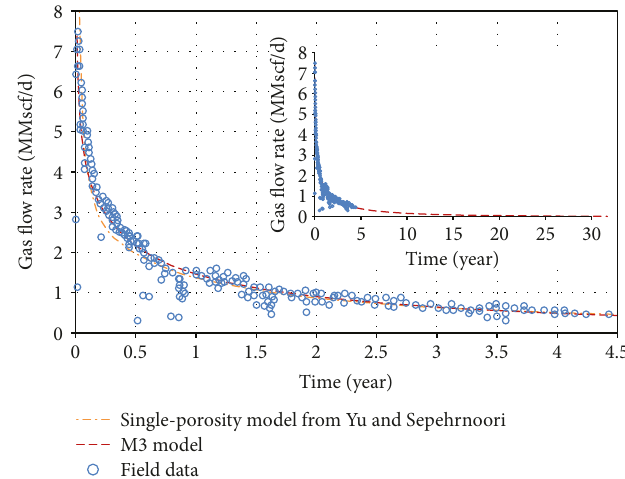
Figure 2: History matching of Barnett Shale with simulation result.